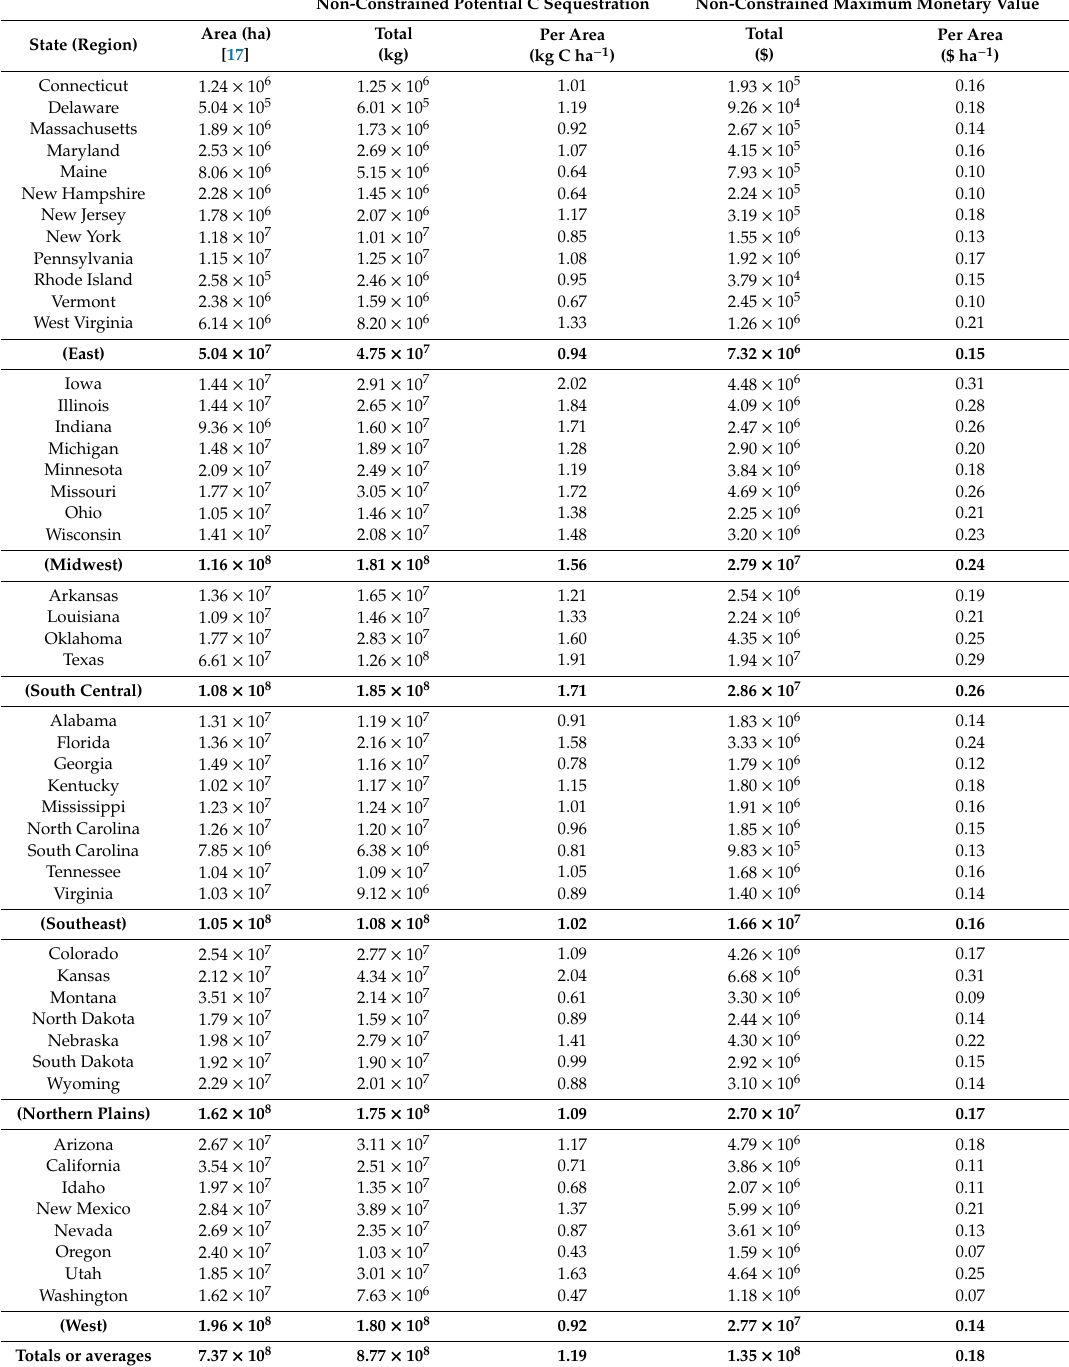
Table 6. Average annual total and area-normalized non-constrained potential soil inorganic carbon (SIC) sequestration from combined atmospheric Ca 2 + and Mg 2 + deposition (2000–2015) for each state (region) within the contiguous United States (U.S.) based on an avoided SC-CO 2 of $42 per metric ton of CO 2